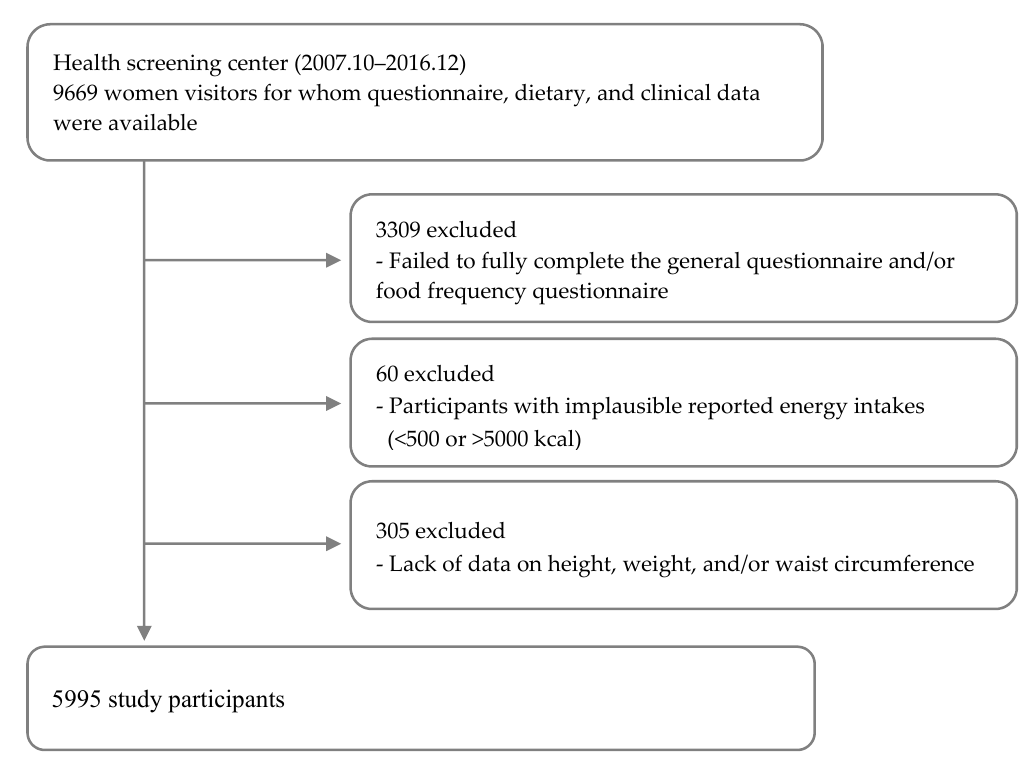
Figure 1. Flow chart of study selection process.